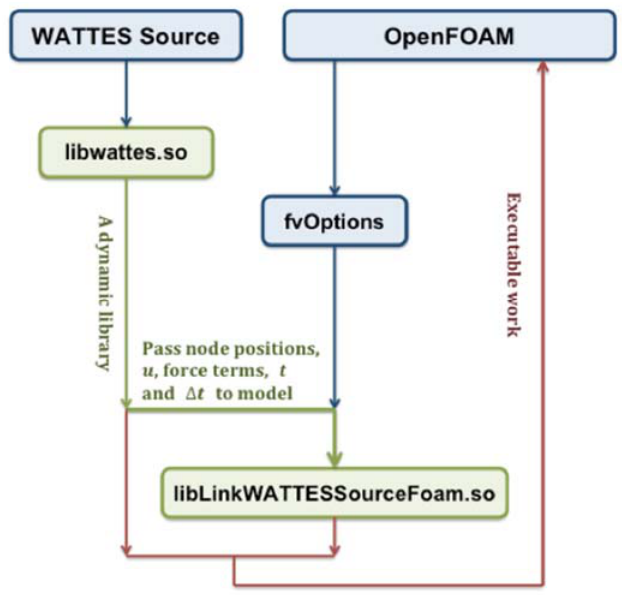
Figure A1. Flow chart of coupled OpenFOAM ‐ WATTES program.